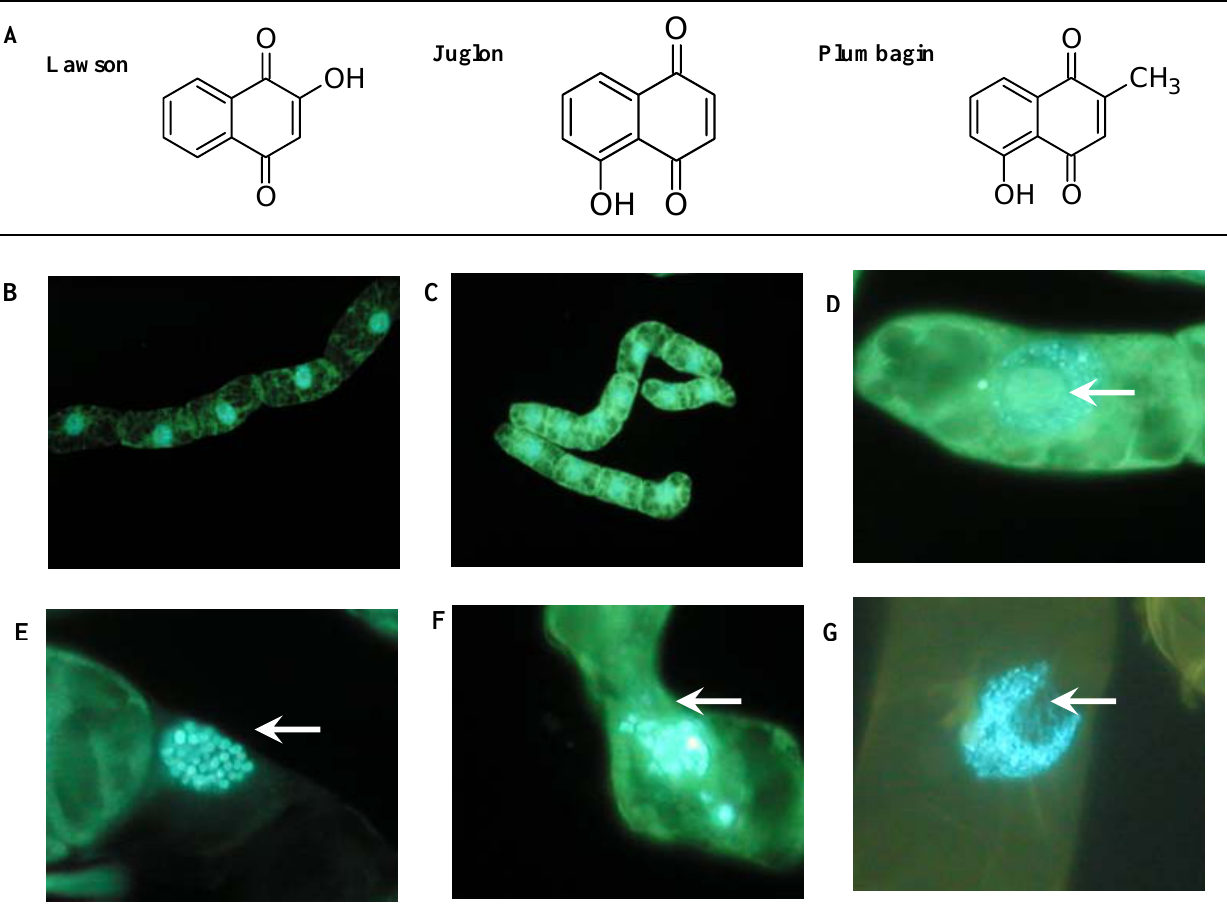
Figure 1. ( A ) Chemical structures of lawsone, juglone and plumbagin. The morphological changes of BY-2 cells induced by the naphthoquinones juglone and plumbagin. The tobacco cells were fixed and dyed with fluorescent dye Hoechst 33258 and observed by epifluorescent microscopy. ( B ) Control, non-treated BY-2 cells. ( C-G ) The tobacco cells treated by plumbagin and juglone (500 µg.l -1 ) for 24 hours; ( C ) overall insight; ( D ) beginning chromatin condensation on the nuclear periphery – pre-apoptotic nucleus; ( E ) apoptotic nucleus – plumbagin; ( F ) apoptotic nucleus – juglone; ( G ) – nucleus with strong chromatin condensation. The arrows show on described phenomenon. Magnification of the figures: ( B-C ) × 400 and ( D-F ) ×